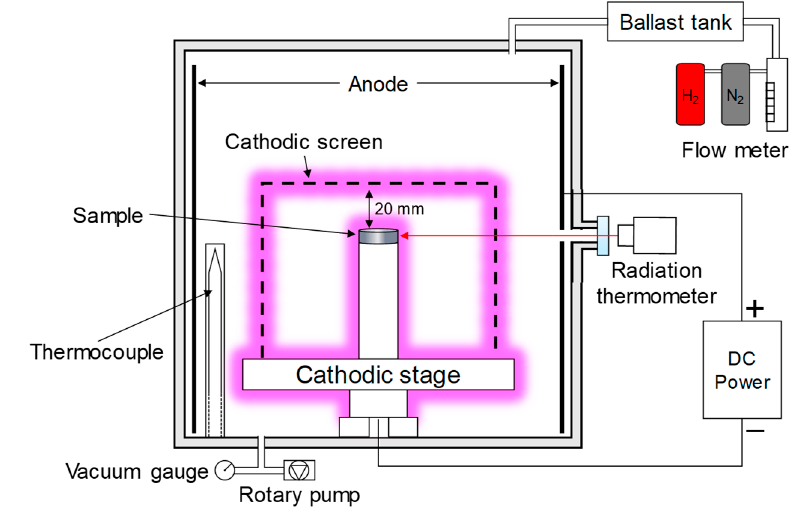
Figure 2. Schematic of the setup for plasma nitriding.